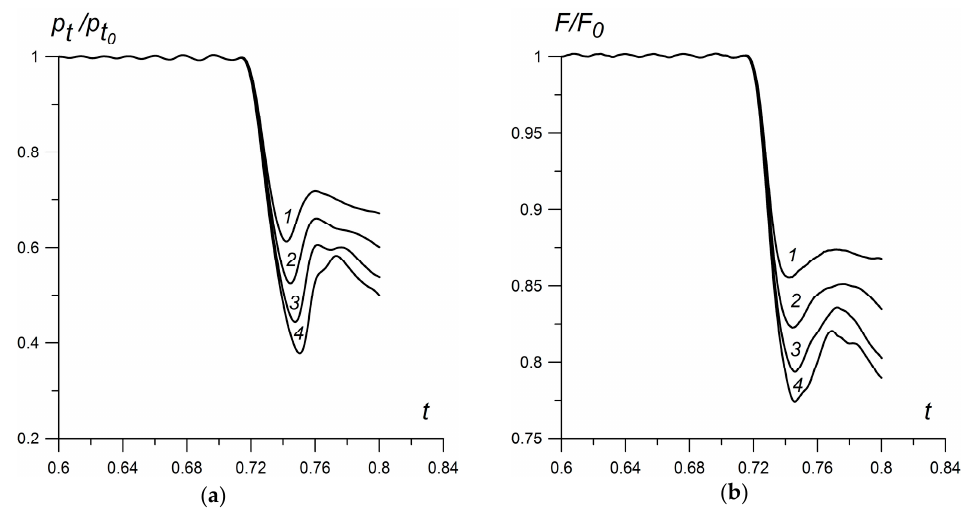
Figure 10. Dynamics of the related stagnation pressure ( a ) and front drag force ( b ) for different α ρ , M = 4, γ = 1.2: curve 1: α ρ = 0.67 ( ω 1 = 55°), curve 2: α ρ = 0.59 ( ω 1 = 50°), curve 3: α ρ = 0.5 ( ω 1 = 45 °), curve 4: α ρ = 0.41 ( ω 1 = 40°).